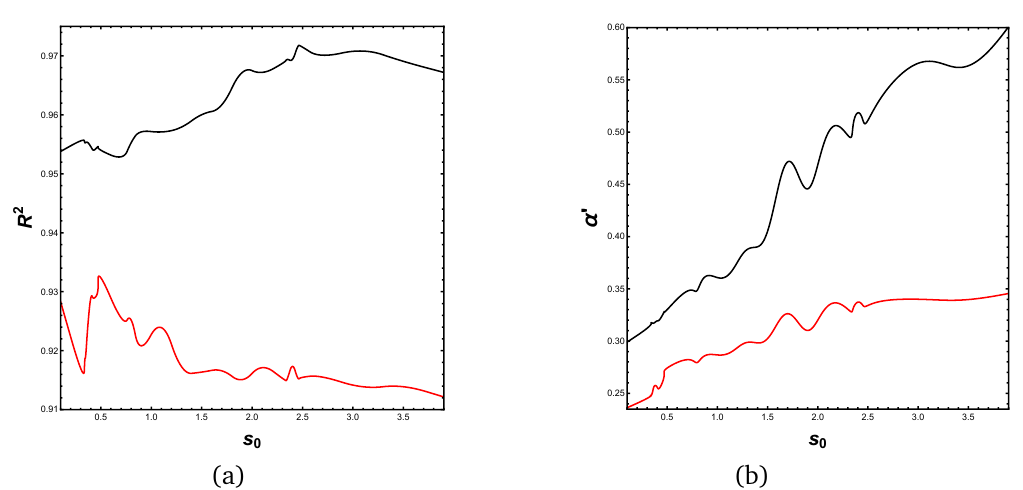
Figure 6: (a) Variation of best-fit R 2 for the S-matrices on the minimum line. Only even spins are considered. An average R 2 > 0.95 shows that all such S-matrices show good linearity (b) Variation of best-fit slope( α ′ ) of the S-matrices as a function of s 0 .